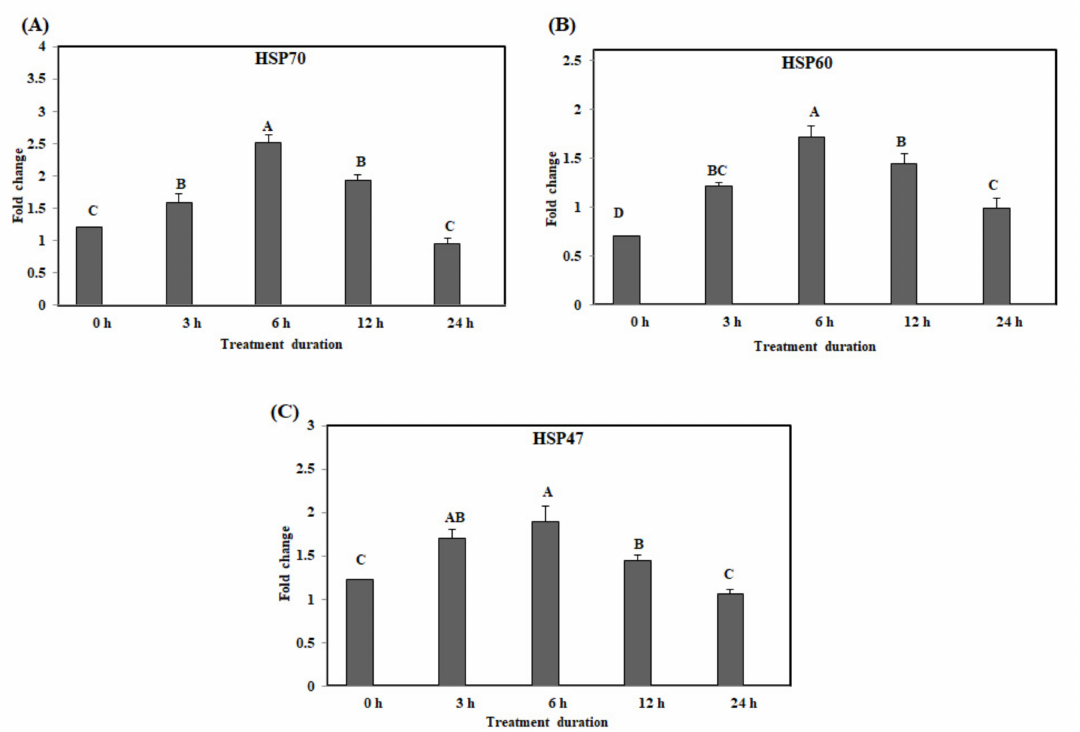
Figure 1. The mRNA expression of the heat shock proteins in the duodenum of chickens exposed to acute heat stress for di ff erent durations of time ( n = 8). The mean relative expression of HSP70 ( A ), HSP60 ( B ), and HSP47 ( C ). A–D HSP70 , HSP60 , and HSP47 in the columns with di ff erent superscript letters di ff er significantly ( p < 0.05) among the di ff erent heat exposure